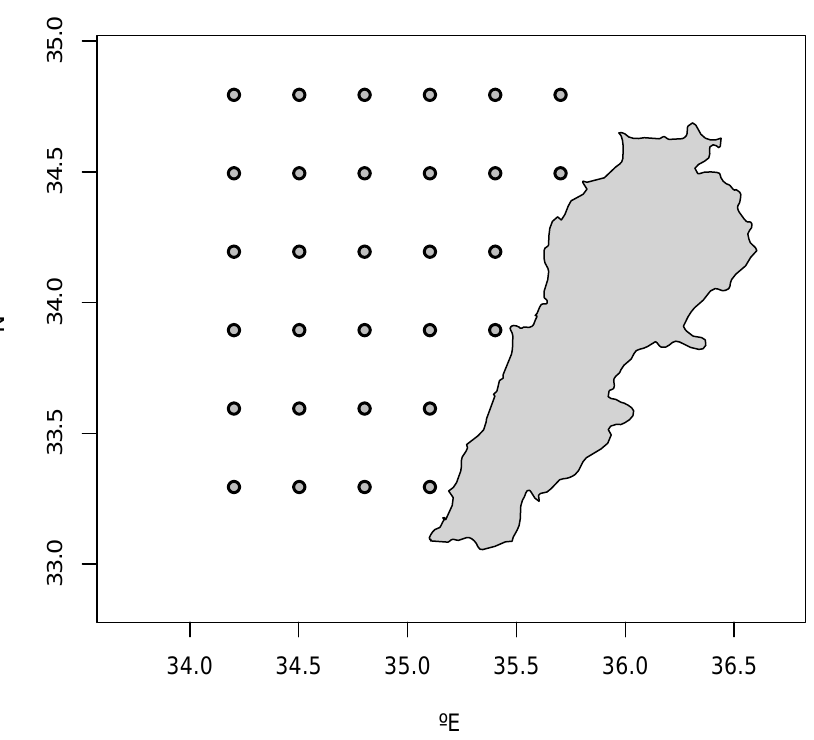
Figure 2. Location of ERA5 gridpoints on the study